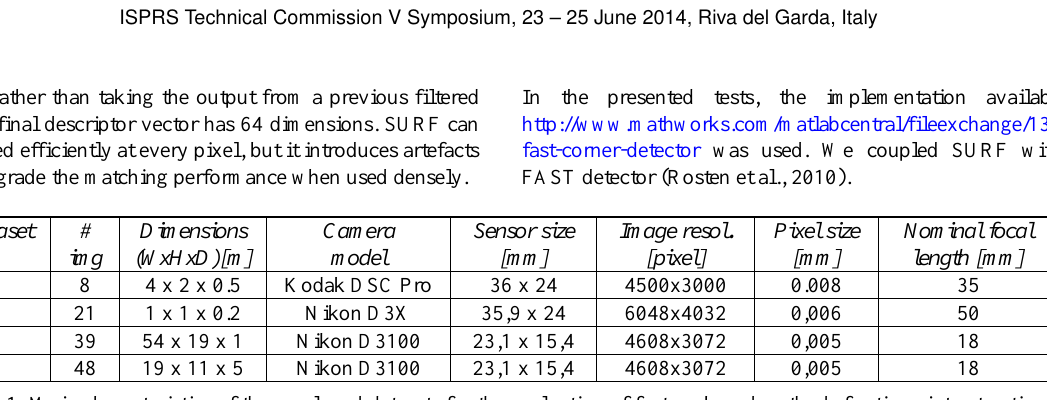
Table 1: Main characteristics of the employed datasets for the evaluation of feature-based methods for tie point extraction. A: Jaguar